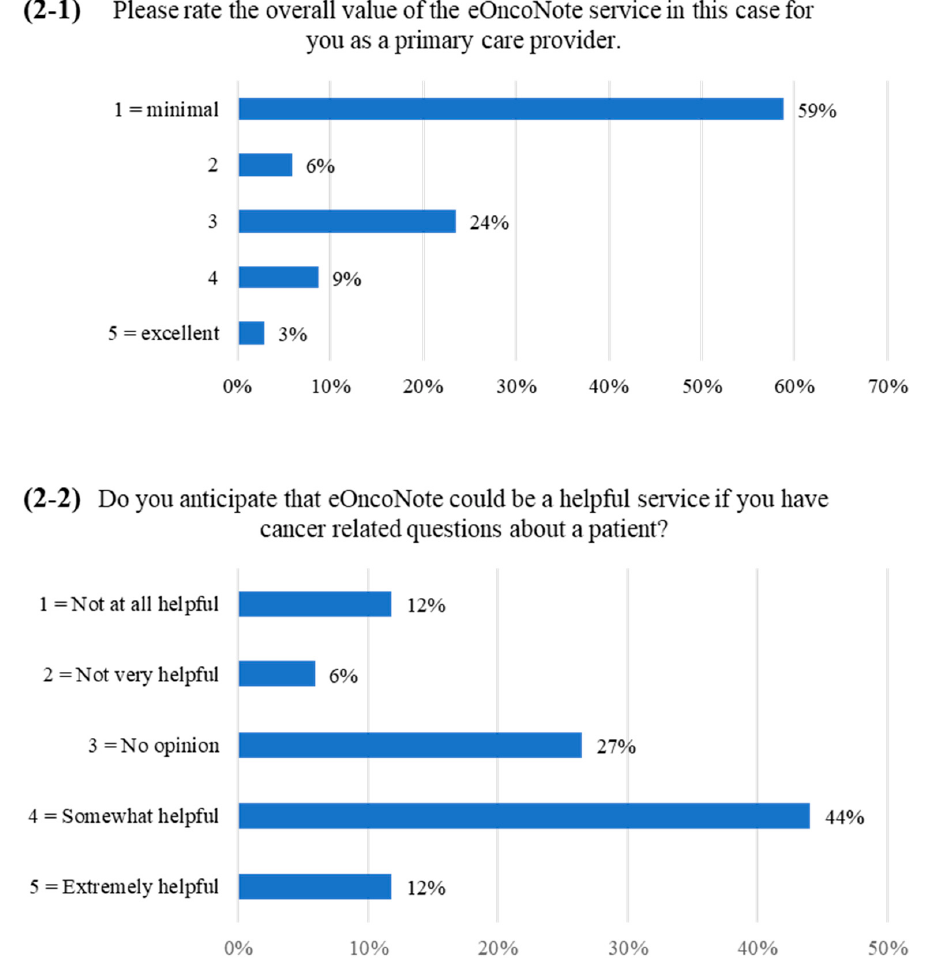
Figure 2. PCP survey responses (( 2-1 , 2-2 ) correspond to items 4 and 5 on the survey,